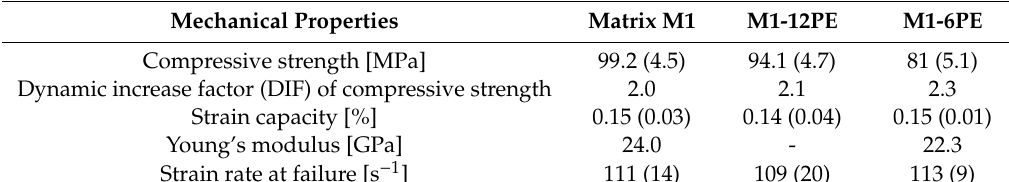
Table 4. Mechanical properties of the matrix and SHCC mixtures obtained in impact compression tests (standard deviations are given in parentheses).